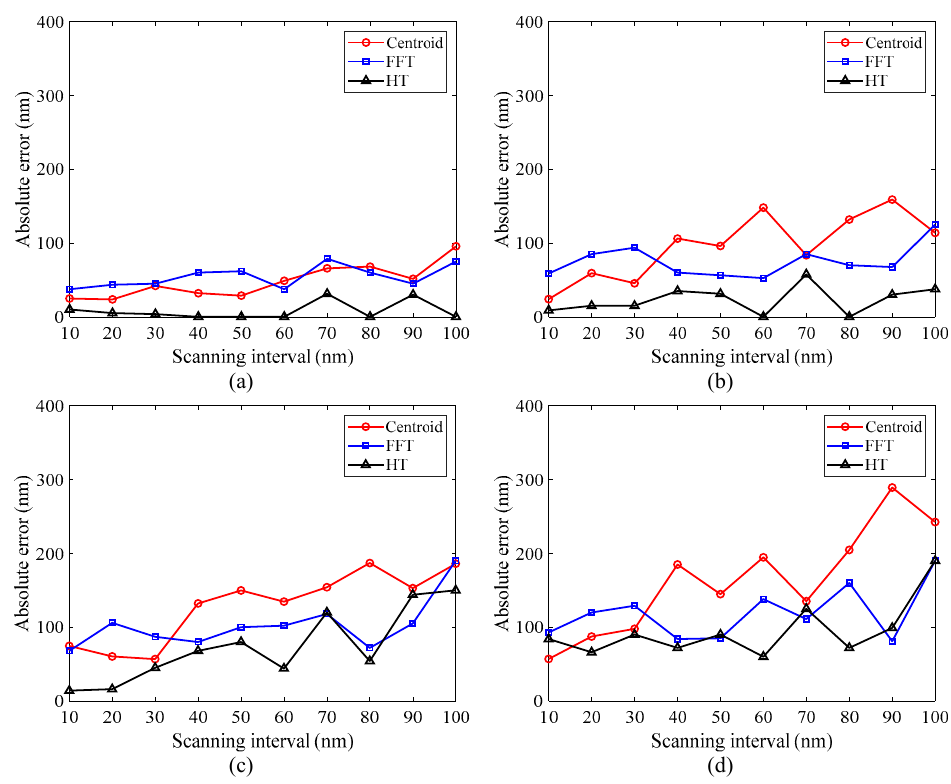
Figure 5. Comparison of errors introduced by the scanning interval under different noise levels: ( a ) 5% random noise, ( b ) 10% random noise, ( c ) 15% random noise, and ( d ) 20% random noise.